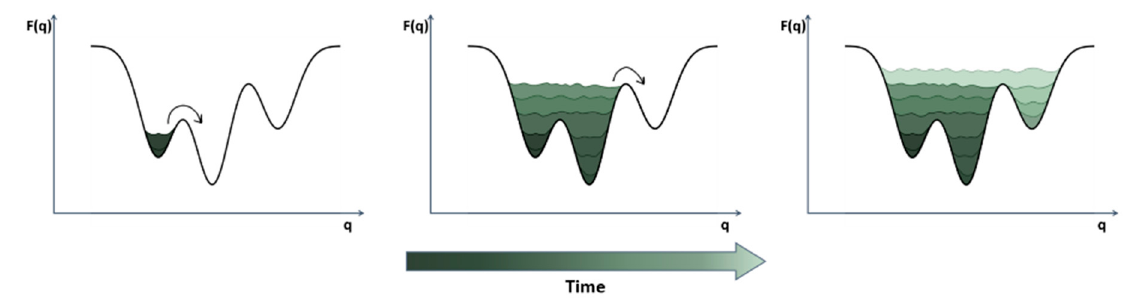
Figure 3. In metadynamics the bias is applied to a CV ( q ) in order to fill the underlying free energy ( F ( q )) and discouraging the system to visit already sampled states.